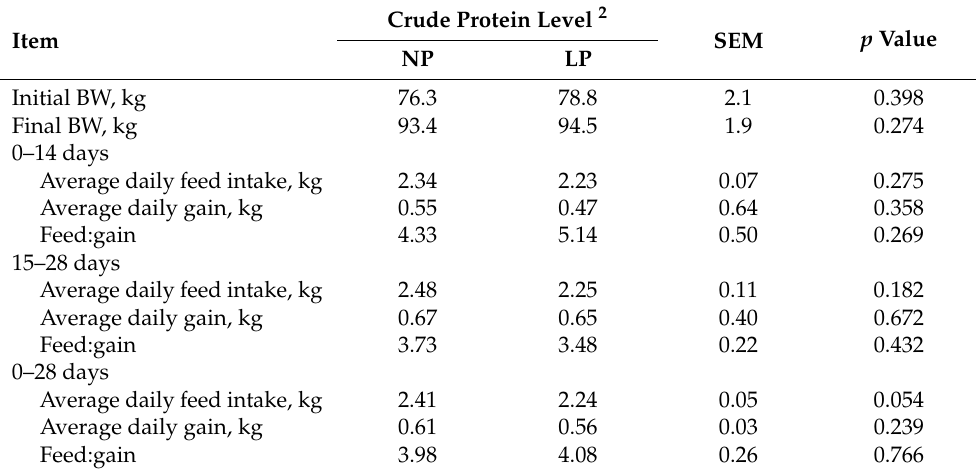
Table 2. Effects of dietary crude protein level on the growth performance of finishing pigs 1 .